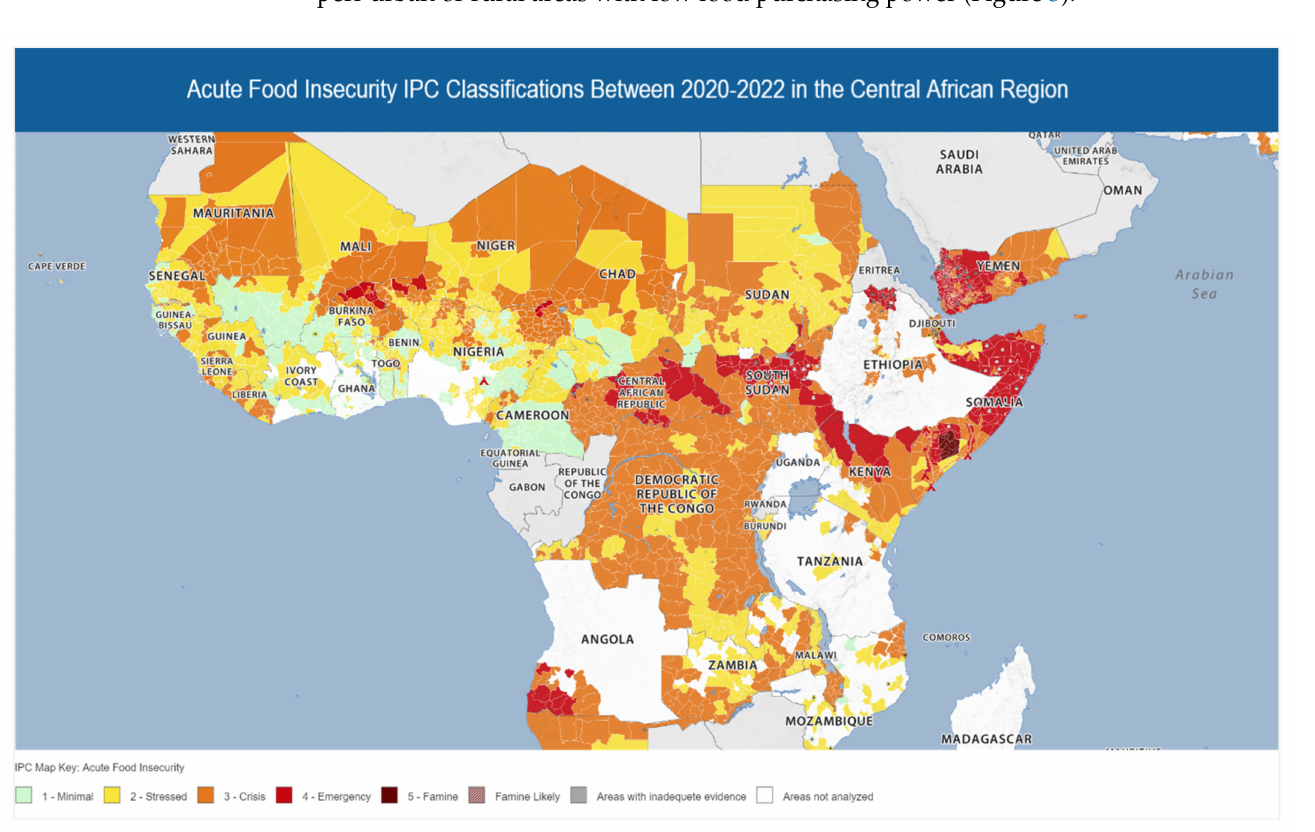
Figure 3. Acute food insecurity classifications based on the IPC between the years 2020 and 2022 in the Central African Region. The image is adapted from the IPC